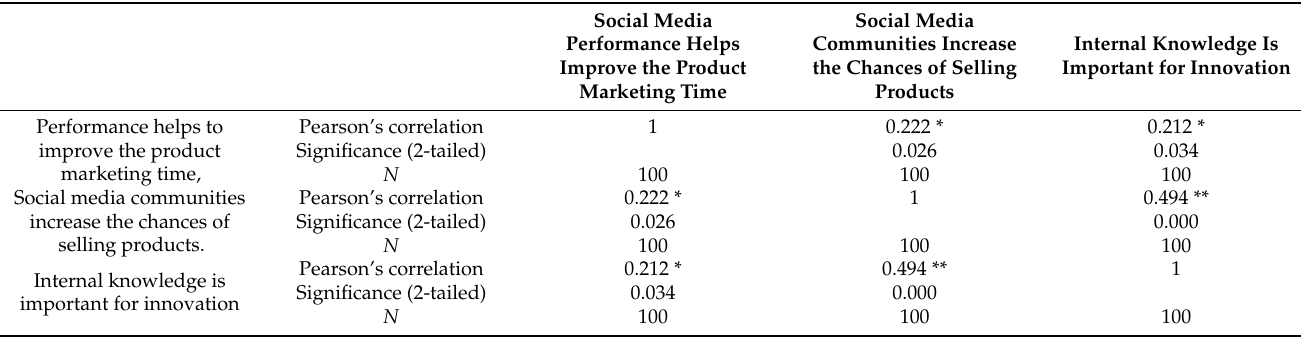
Table 9. Correlations between the independent and dependent